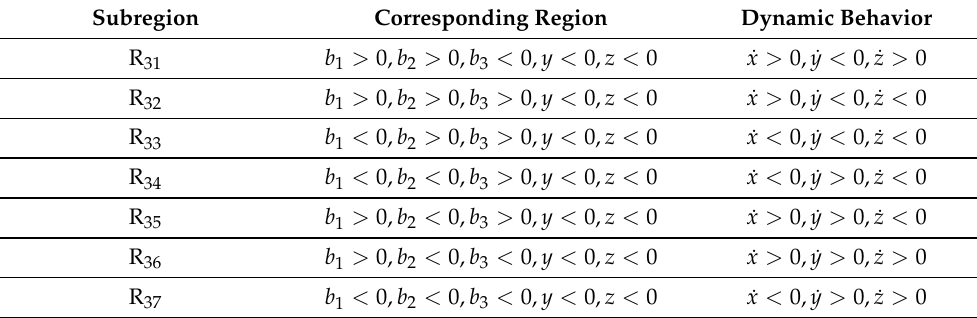
Table 4. Dynamic behavior of the trajectories in the seven subregions. Subregion Corresponding